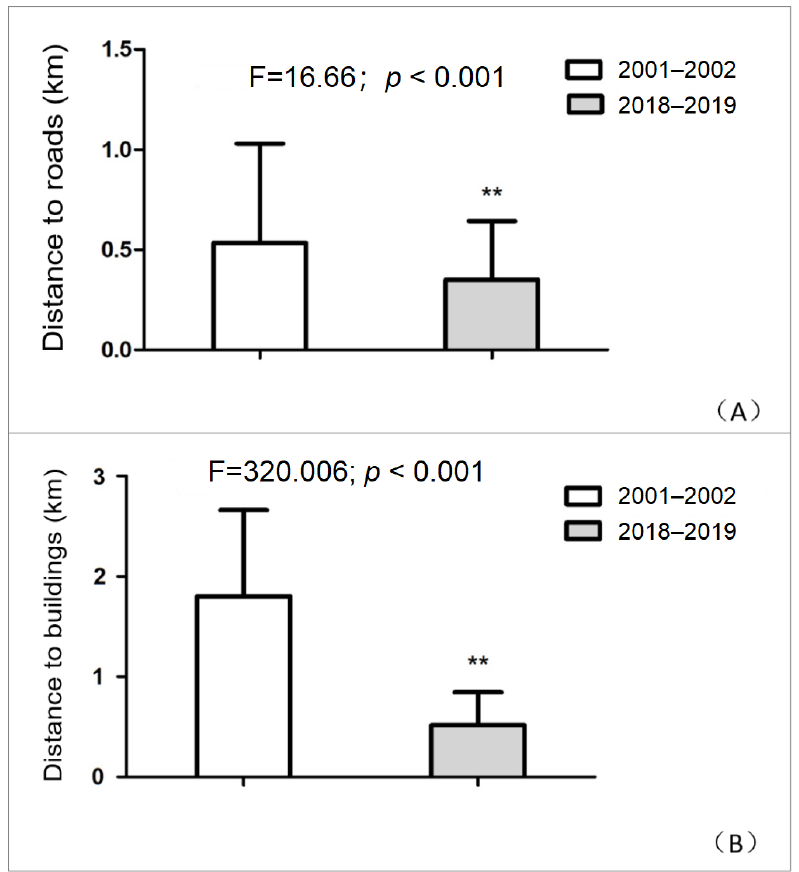
Figure 4. Distance between Reeves’s pheasant presence locations and the nearest ( A ) road and ( B )